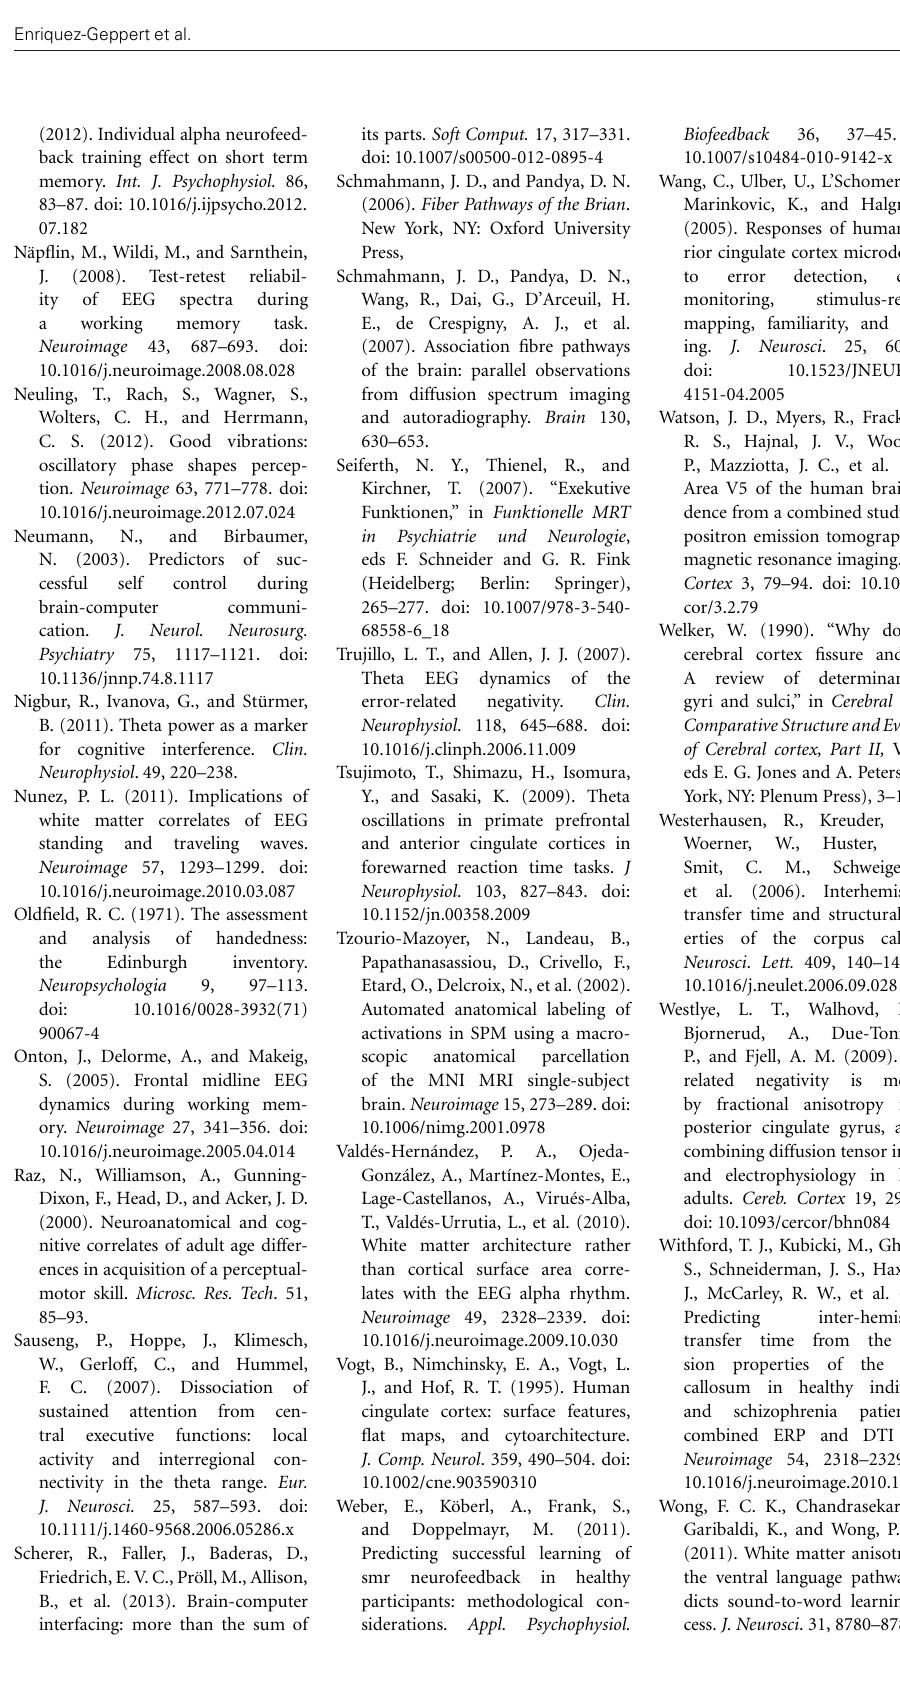
Figge C, Zimmermann J and Herrmann CS (2013) The morphology of